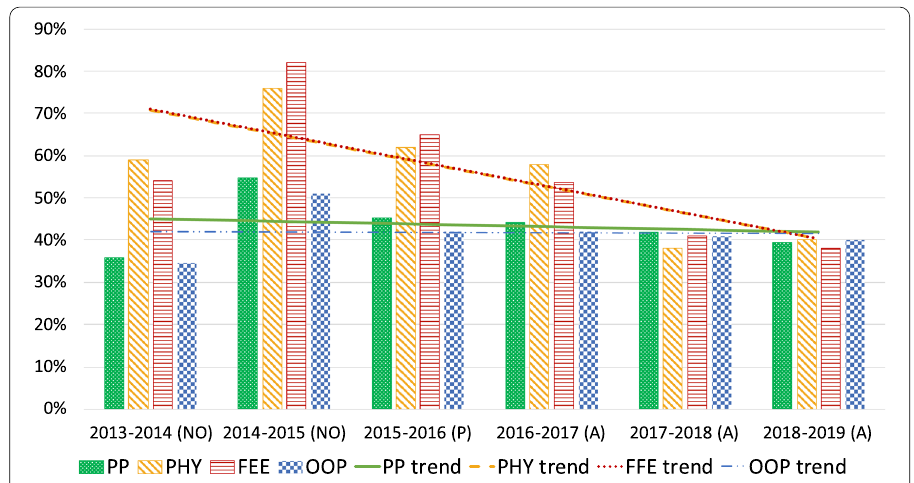
Fig. 8 Trending lines for the percentage of students that passed the final exam on Computer Programming (CP), Physics (PHY), Foundations of Electrical Engineering (FEE) and Object Orienting Programming